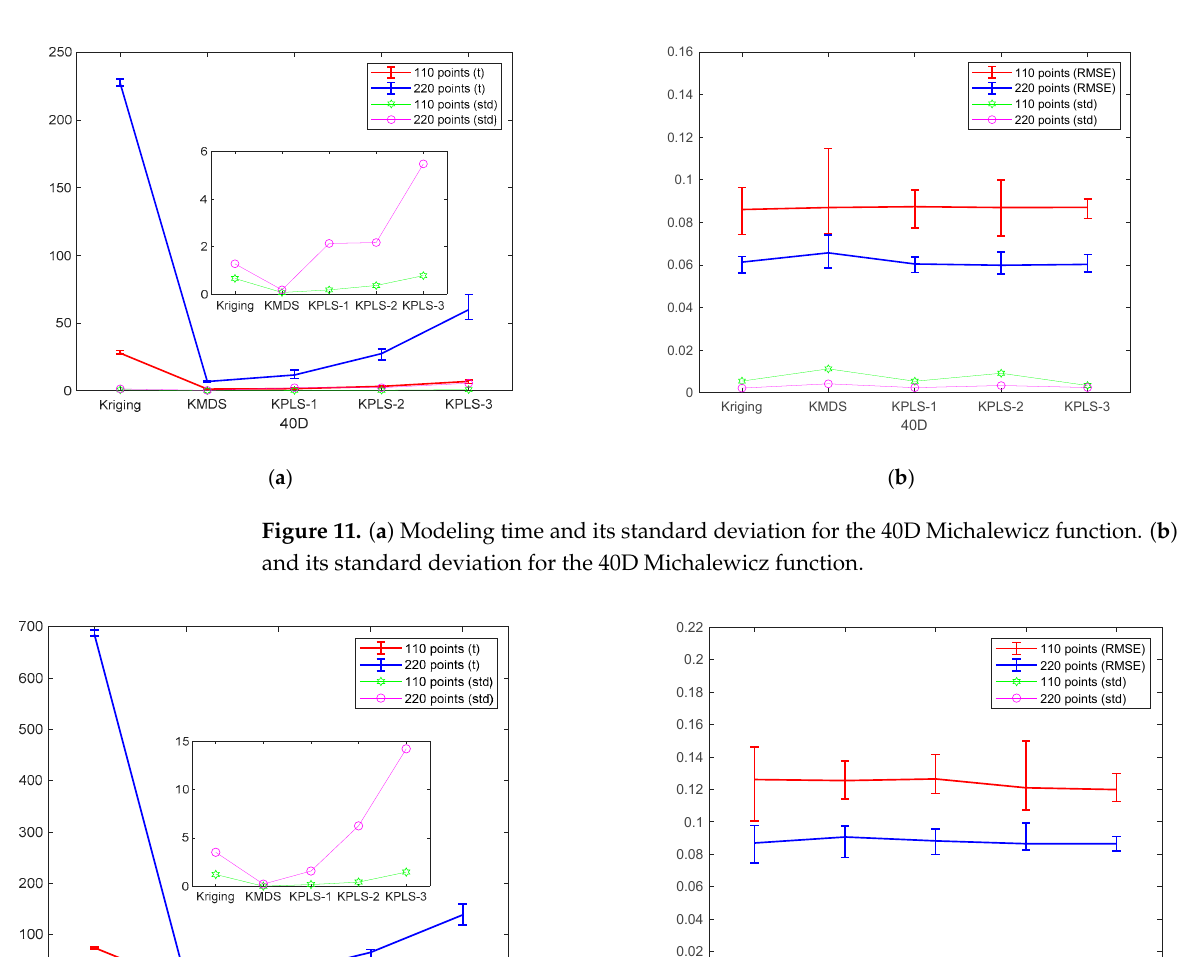
( b ) Figure 10. ( a ) The average change trend for the modeling time for the 40D Michalewicz function. ( b ) The average change trend for RMSE for the 40D Michalewicz function. From Table 5, it is easy to see that the test results for the Michalewicz function are similar to those of the Griewank function and the Rothyp function. However, in the case of 40D and 110 sampling points, the test results of the Michalewicz function are slightly different: the modeling time of KMDS is still the shortest, while the modeling error of the ordinary Kriging method is slightly smaller than that of the KMDS method. The complex-